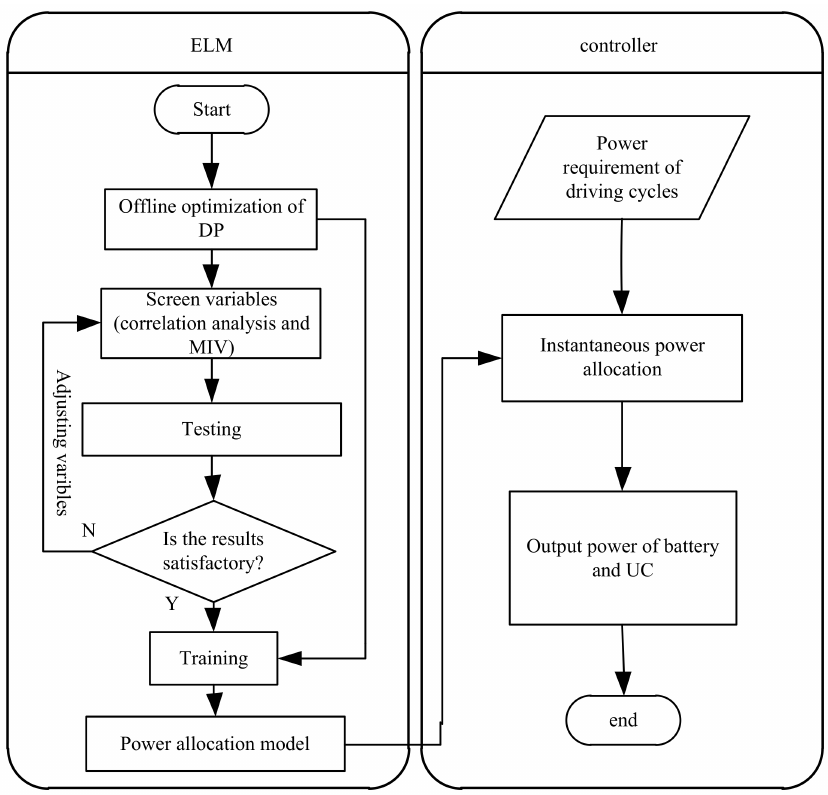
Figure 6. Design process of the ELM-based